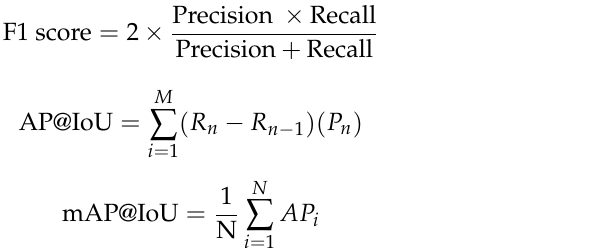
Figure 6. Pinhole camera model. 4. Results 4.1. Object Detection Algorithm Performance Comparison Deep learning model development and training were performed using the Darknet repository, a neural network framework developed by Joseph Redmond [44]. The com- puter environment was Google Colab Pro, which provides high-performance computing specifications with Tesla K80 with 12GB GPU memory. Table 4 lists the library environ- ments such as CUDA, CUDNN, and TensorFlow. The learning parameters were set to a learning rate of 0.9 momentum, decay of 0.0005, batch size of 32, and a subdivision of 16. The input image size was fixed at 416 × 416, and the mix-up augmentation during the training phase was set to True so that input image size could be randomly changed during the training phase. We set the confidence value as 0.25 and the IoU threshold as 0.5 for the proposed SPFPN-YOLOv4 tiny, and other YOLO models to detect potholes accurately. Comparing the training mAP for each model as shown in Table 5, it was confirmed that SPFPN-YOLOv4 tiny achieved not only the